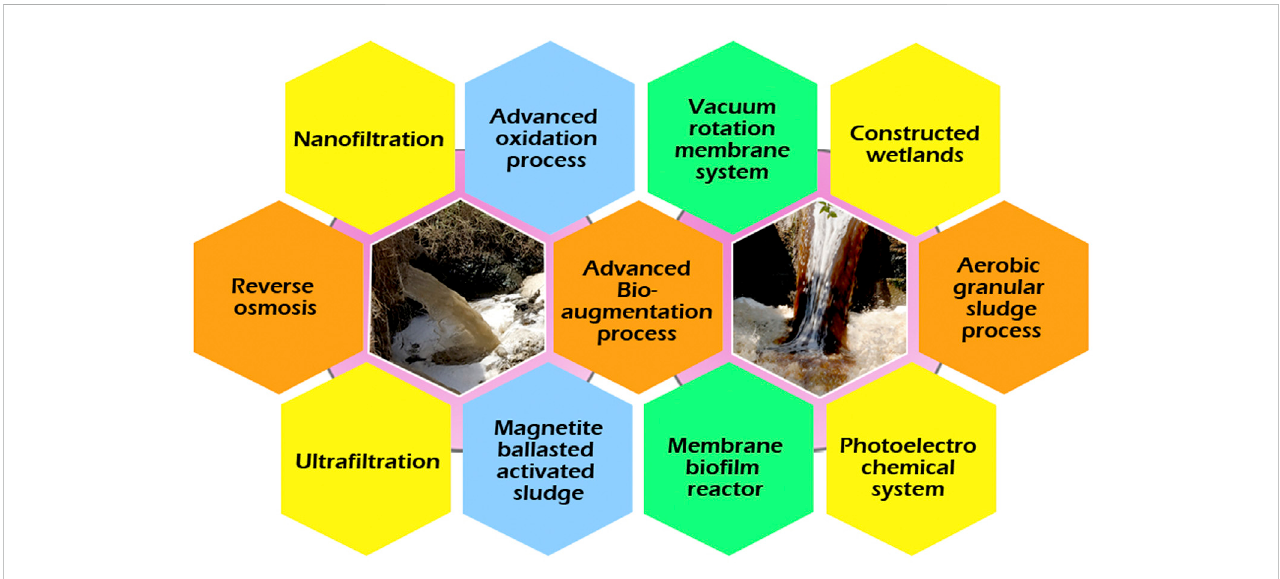
FIGURE 1 Emerging approaches used for wastewater